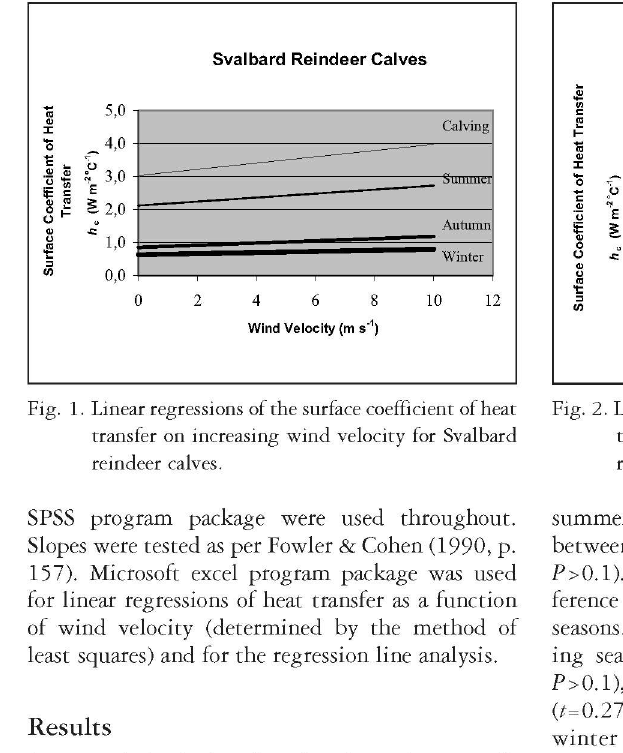
Fig. 1. Linear regressions of the surface coefficient of heat transfer on increasing wind velocity for Svalbard reindeer calves.